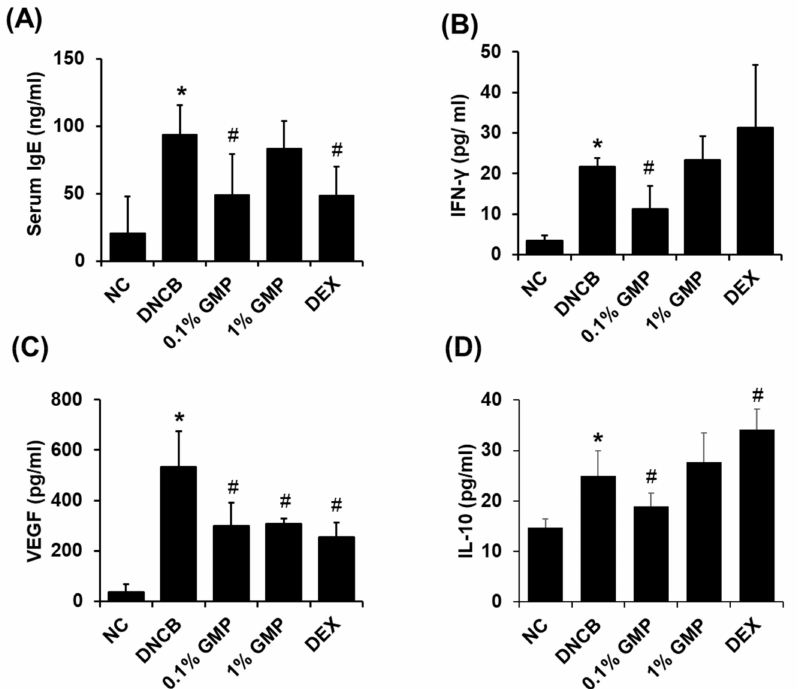
Figure 3. Effect of GMP on serum IgE and inflammatory cytokines. Serum IgE and cytokine levels were evaluated by ELISA. ( A ) Serum IgE level. ( B – D ) Levels of inflammatory cytokine IFN- γ , VEGF, and IL-10 in the skin lesions. Data represent the means ± SDs. * p < 0.05 vs. the NC group, # p < 0.05 vs. the DNCB